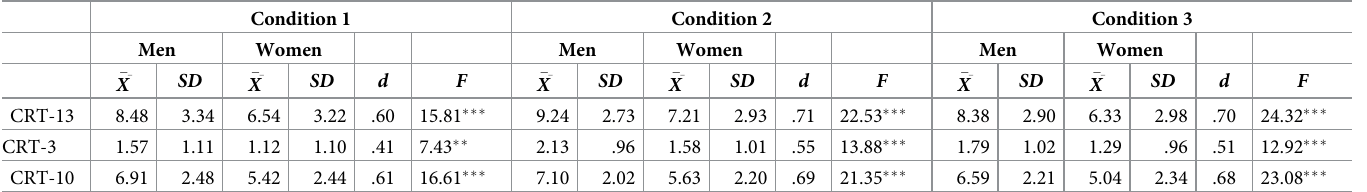
Table 3. Sex differences in CRT scores according to experimental conditions.